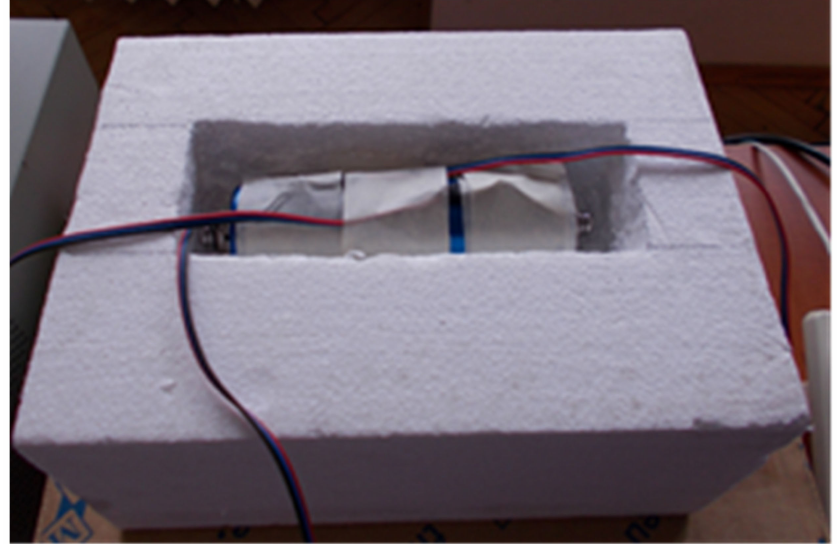
Figure 6. Layout for cells testing under restricted conditions of heat transfer. The performance of the cell in the case of its full discharge (to around 9% of the rated value) was also examined. Such a situation can often be met in practice when, e.g., the operator forgets to disconnect the load. The tests were performed for three cells of the same type. Each measurement of both the temperature at T 1 and the cell voltage was